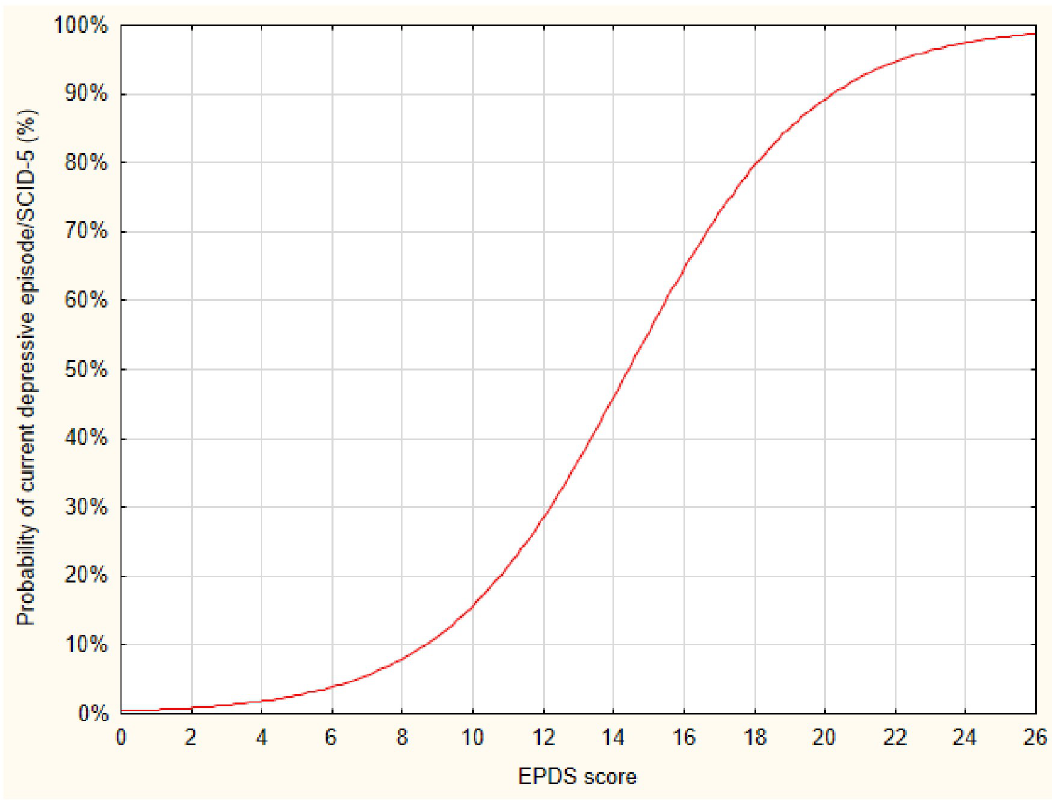
Fig 1. Probability of positive screening for current depressive episode (SCID-5) according to EPDS. Logistic regression: p < 0,001 dependent variable: depressive episode/SCID-5; independent variable: EPDS score.